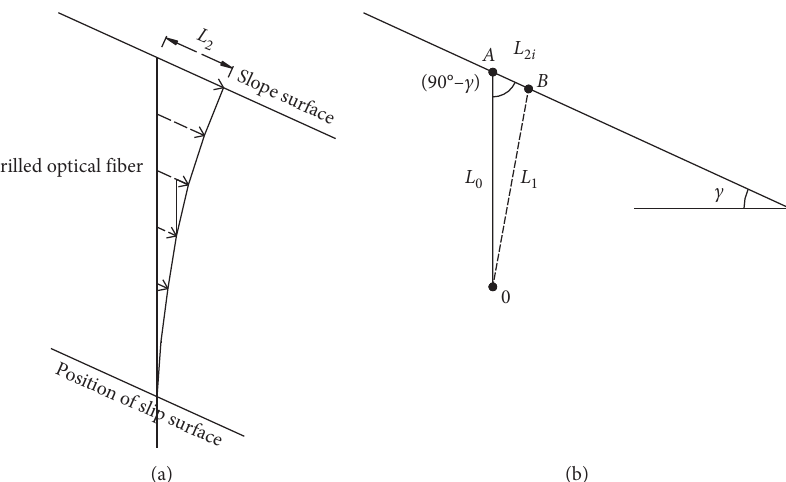
Figure 4: Schematic diagram of calculating the landslide internal deformation using fiber grating. (a) Calculation diagram of deflection curve. (b) Calculation diagram of deflection